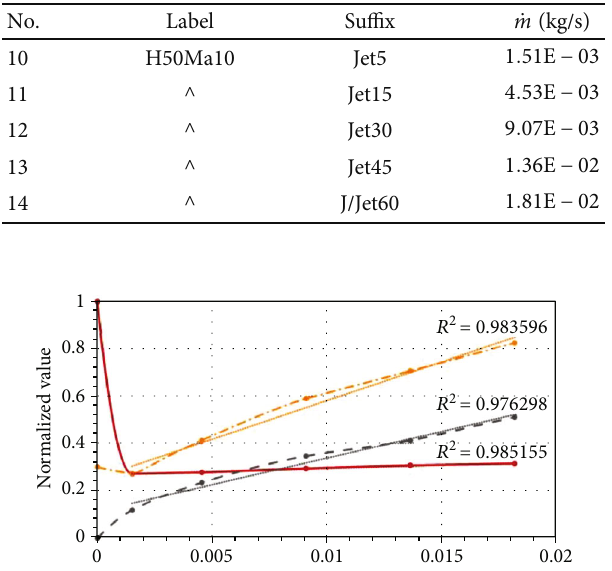
Table 5: Mass fl ow rates of the H50Ma10 series.